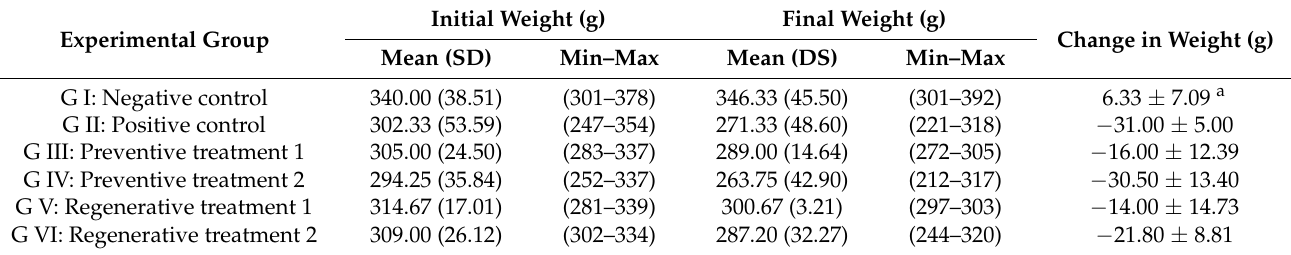
Figure 4. Results regarding initial weight and final weight in the experimental groups. Table 3. Weight of the rats in each phase of the experiment.